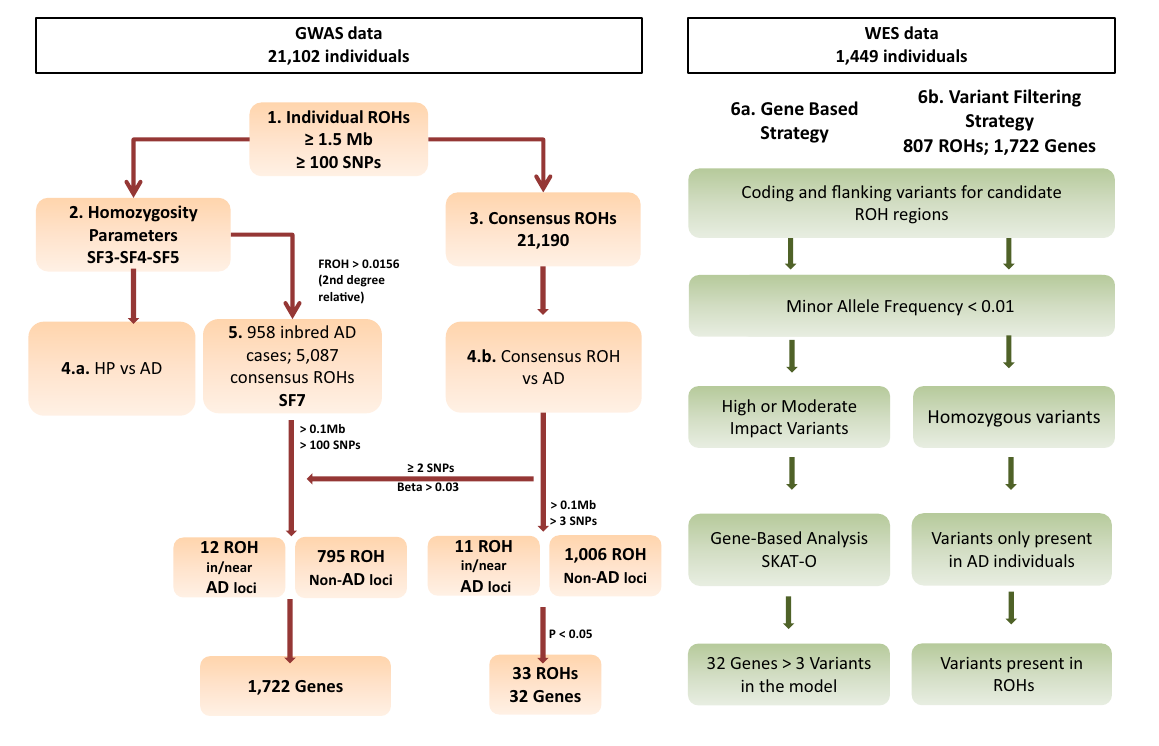
Fig. 1 Schematic of the stepwise for ROH prioritization. 1. Identi fi cation of ROH segments per individual; 2. Estimation of: homozygosity parameters, and 3. Consensus ROHs; 4. Association analysis between: a) Homozygosity parameters and AD status, and b) Consensus ROH and AD status; 5. Identi fi cation of inbred AD cases and ROH prioritization; 6. Exploration of selected ROH segments in WES data applying: a) Gene-based strategy, and b) Variant fi ltering